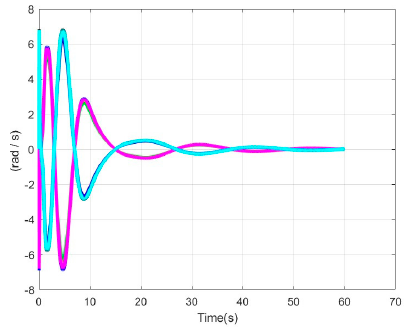
Figure 16. Angular speeds of